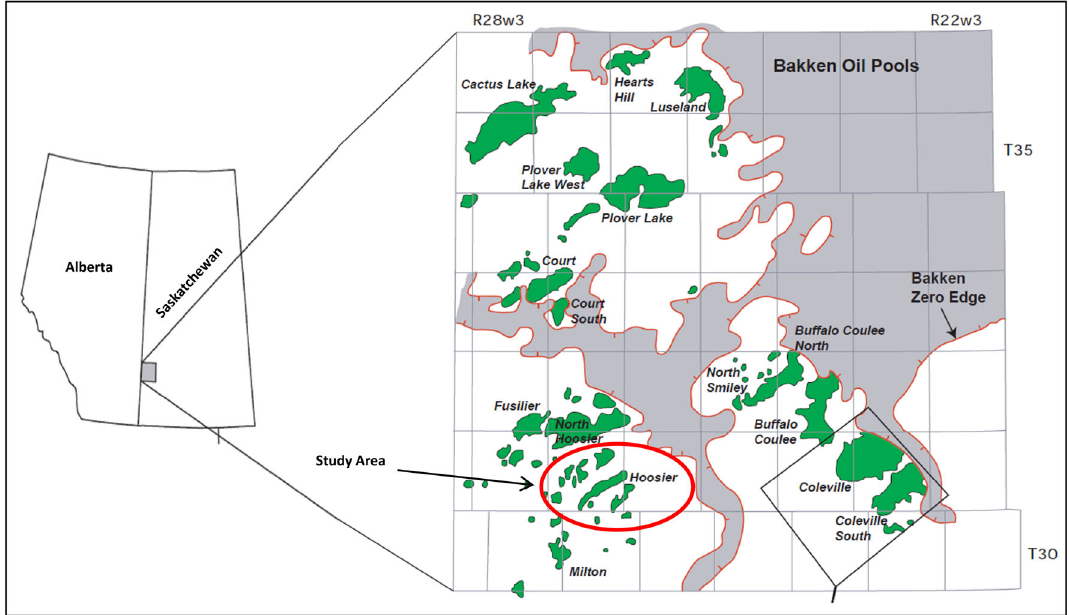
Fig. 2 Location Map of study area showing the Hoosier field. Modified after O’Connell et al.